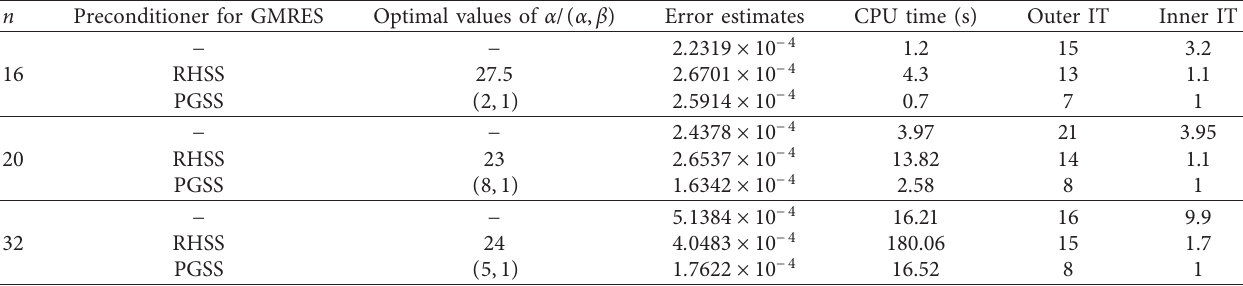
Table 7: Numerical results of preconditioned inexact Newton methods for v � 0.1 and η � 0.4. n Preconditioner for GMRES